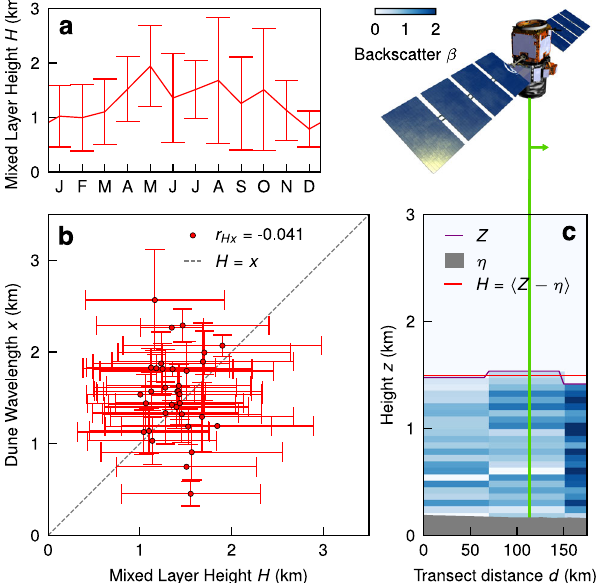
Fig. 3 Mixed layer heights over dune fi elds. a An example mixed layer height H annual climatology for the Rub Al Khali measured using CALIPSO for 2006 – 2019. Monthly means and standard deviations given ( n = 222). b H and measured dune wavelengths x for 34 dune fi elds in the geometry data set, means (red dots with black outlines) and standard deviations (red lines) for both measurements are shown, as is the Pearson ’ s correlation coef fi cient r Hx and the identity H = x . If two characteristic dunes are identi fi ed in a tile, only the larger one is included in the averaging for this plot. c An example of the H extraction from CALIPSO (pictured) over the Rub Al Khali. As the satellite passes over the dune fi eld (gray region), the CALIPSO (green line) scan of the atmosphere detects high backscatter β from aerosols in the mixed layer relative to the free atmosphere above (blue map, 5-km horizontal resolution). The mean difference (red line) of the delineation between high and low β , Z , (purple line) and elevation η (gray region) for the scan constitutes one H value 20 .